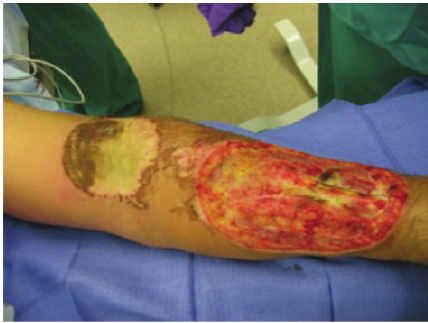
Figure 1: Left upper extremity thermal injury. Figure 2: Radial nerve isolated in center of